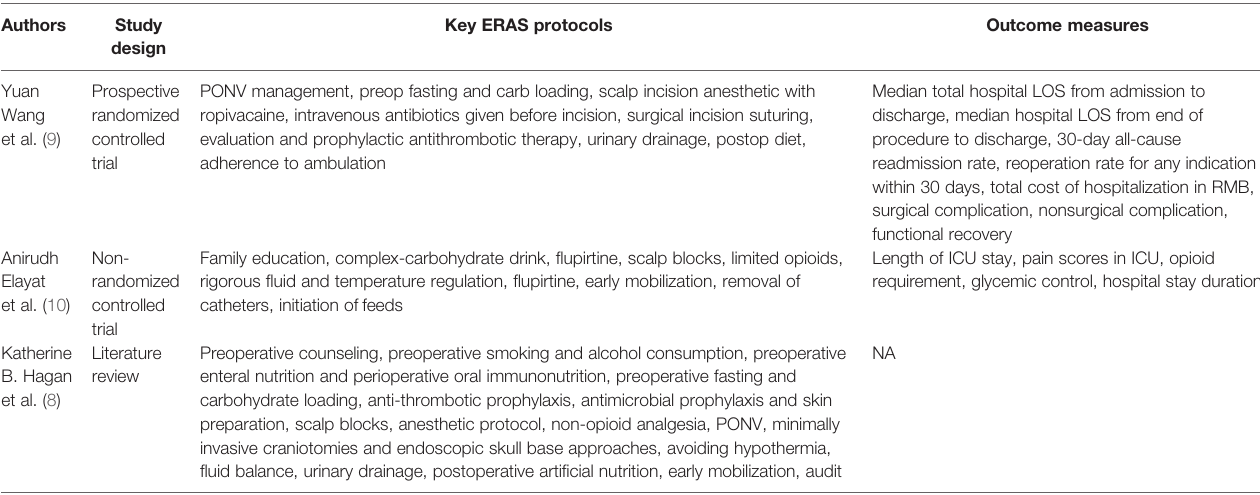
TABLE 7 | Summarization of the ERAS protocols and outcome measures applied in elective craniotomy in the past studies.